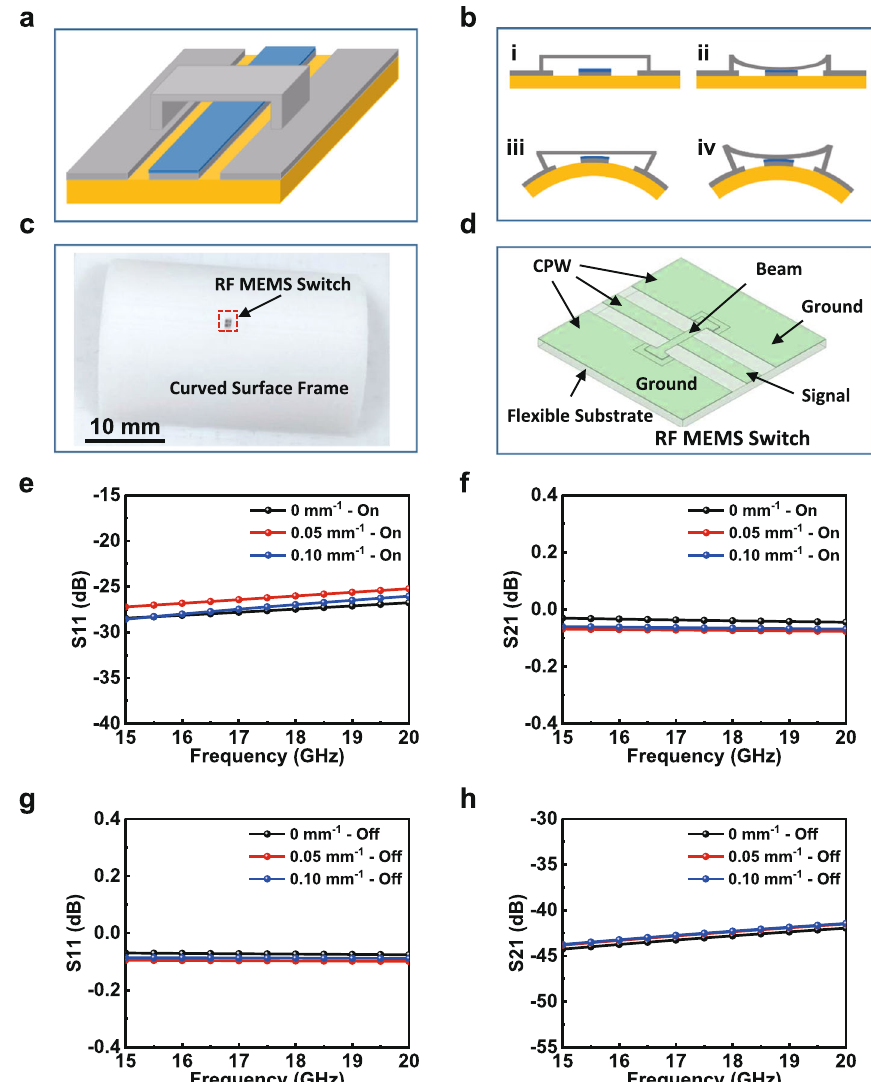
Fig. 1 Miniaturized fl exible RF MEMS switch for large curvature. a Schematic diagram of fl exible double-clamped beam RF MEMS switch. b Con fi guration diagram of fl exible RF MEMS switch in different modes: i) On state and ii) Off state of MEMS switch with fl at substrate; iii) On state and iv) Off state of MEMS switch with curved substrate. c Image of a miniaturized MEMS switch attached to a curved surface. d Structure of miniaturized MEMS switch. e On state S 11 , ( f ) On state S 21 , ( g ) Off state S 11 and h Off state S 21 of membrane beam under different bending